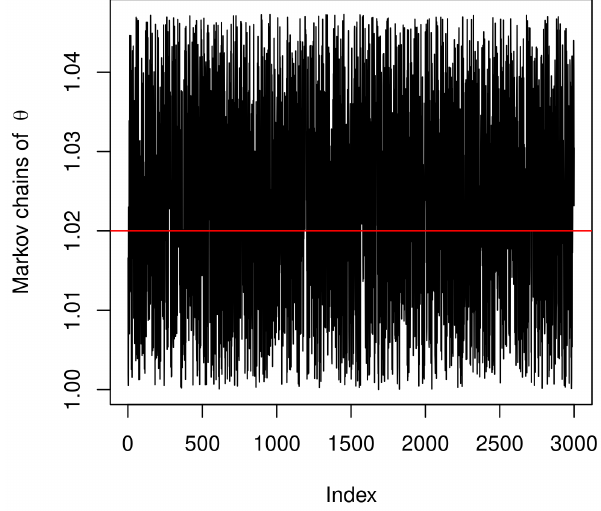
Figure 4. The Markov chains of θ . The horizontal line is the true value of θ